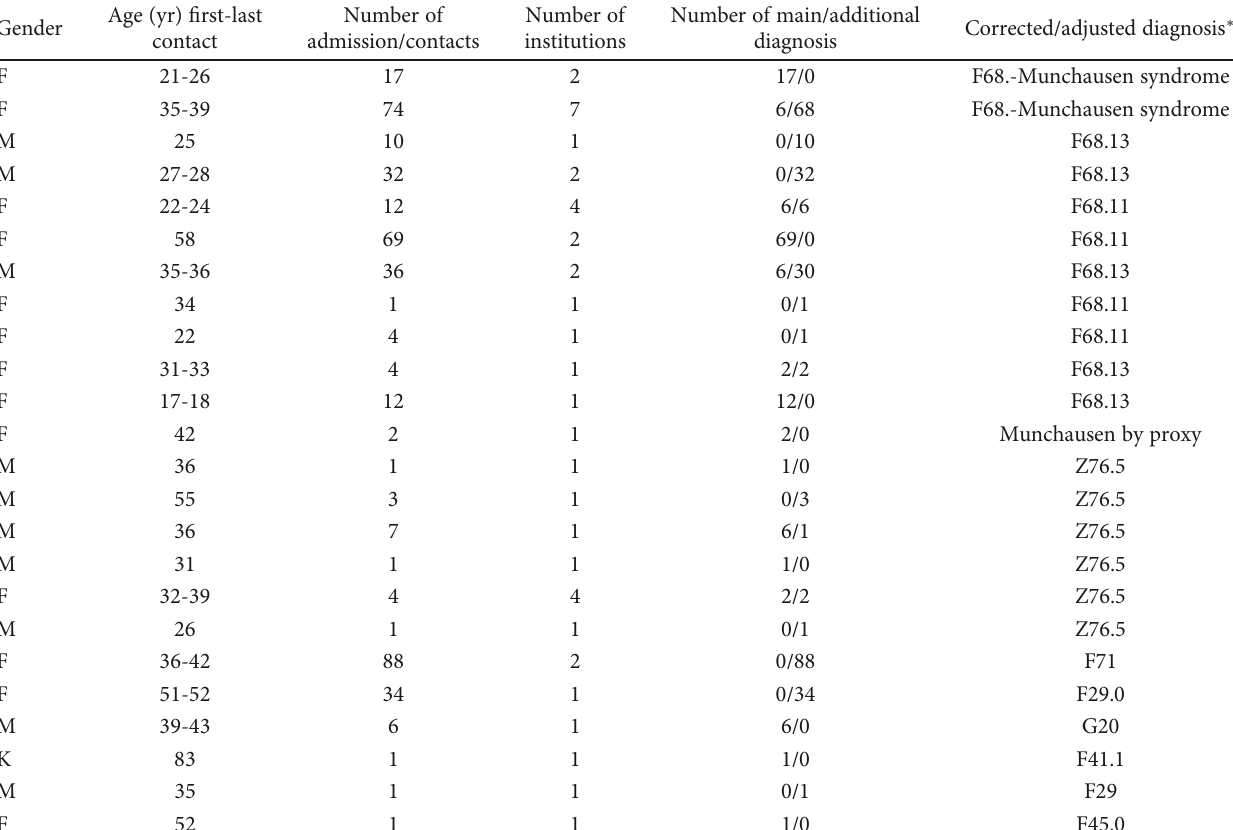
Table 3: List of 24 patients with F68.1 diagnosis from health institutions remembered by healthcare providers.